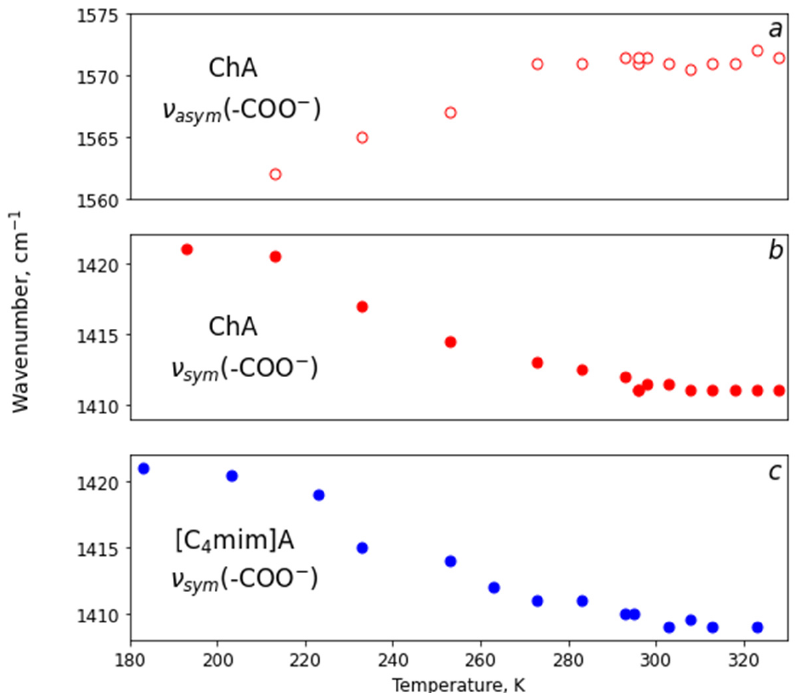
Figure 2. Dependence of the maximums of peaks corresponding with the asymmetrical and symmetrical vibrations of the carboxylate group in ChA ( a , b ) and [C 4 mim]A ( c ) on temperature.